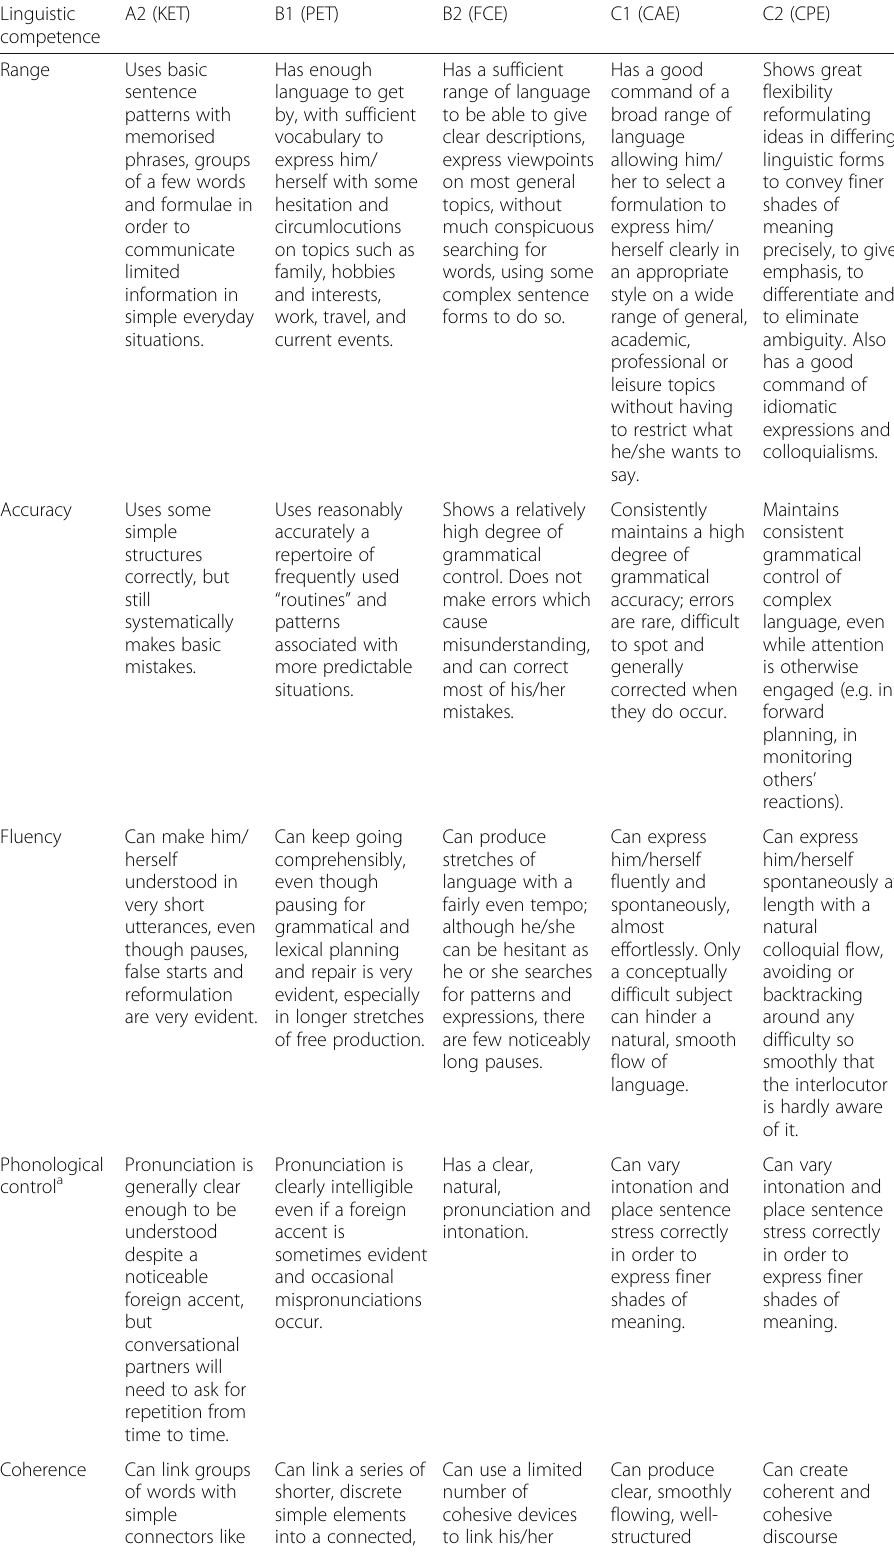
Table 10 CEFR descriptor scales for linguistic competence (Council of Europe 2001, pp. 28, 29, 117) Linguistic A2 (KET) competence